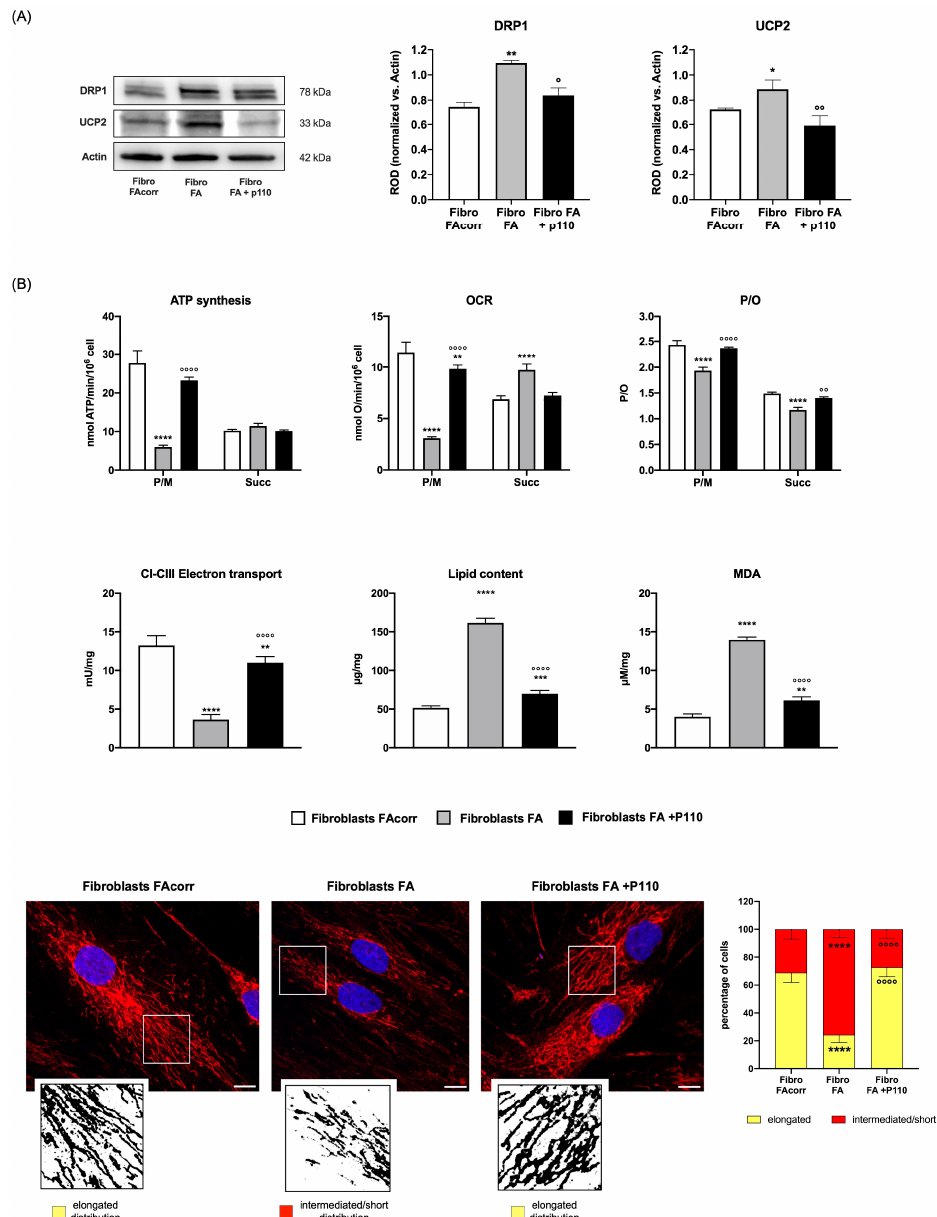
Figure 6. Effect of P110 treatment on DRP1 and UCP2 expression and energy metabolism in fibroblasts mutated for the FANC-A gene. ( A ) WB signals of DRP1 (mitochondrial fission), UCP2 (uncoupling protein 2), and Actin (housekeeping protein used for signals normalization) expression in FAcorr and FA fibroblasts treated or not with P110. For all the densitometry graphs protein expression levels were normalized on the housekeeping signal (Actin), revealed on the same membrane. ( B ) Energy and lipid metabolism in FAcorr and FA fibroblasts treated or not with P110: ATP synthesis, oxygen consumption rate (OCR), and P/O value obtained after stimulation with pyruvate/malate (P/M) or succinate (Succ); electron transport between complexes I and III (CI-CIII); cellular lipid content; malondialdehyde (MDA) level, as a marker of lipid peroxidation. ( C ) Confocal imaging of FAcorr fibroblasts and FA fibroblasts treated or not with P110 stained with antibody against TOM20 (red) and DAPI (blue), to show the mitochondrial reticulum and nuclei, respectively. White scale bars correspond to 10 µm. The higher magnification insert corresponds to the area enclosed by the white square and is an example of mitochondrial network distribution. Fibroblasts were scored depending on the morphology of most of their mitochondrial population as elongated or intermediated/short. Results reported in the histogram on the right show that P110 treatment on FA fibroblasts restores the percentage of cells with elongated distribution, reaching values similar to those of FAcorr cells. Data and WB signals are representative of at least three